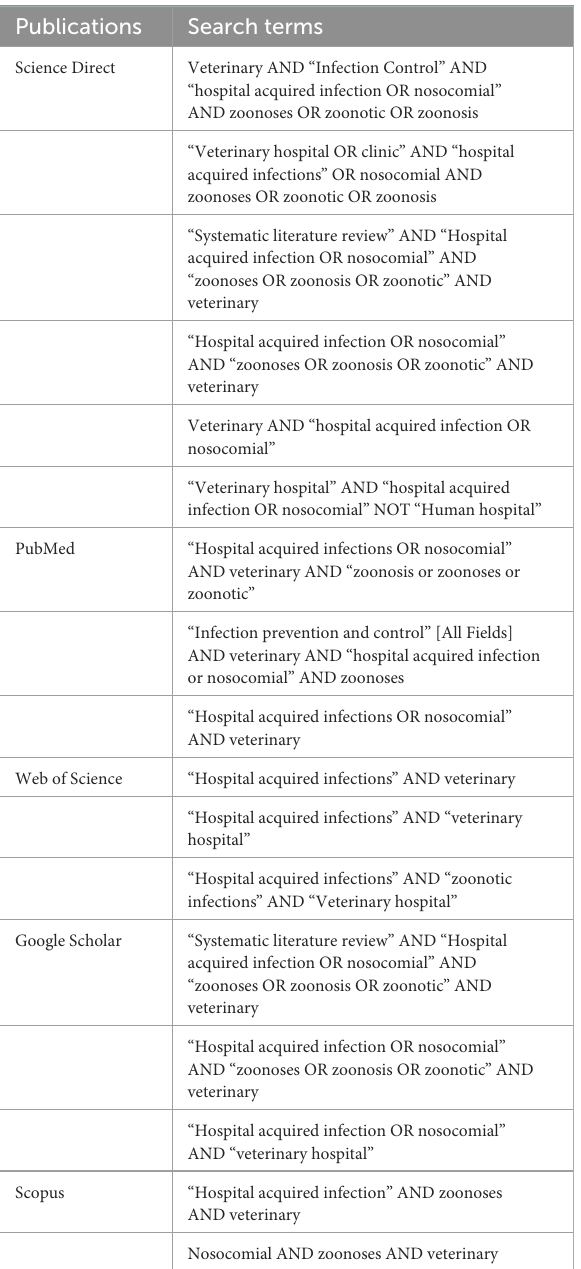
TABLE 2 Inclusion and exclusion criteria of articles reporting on hospital-acquired and/or zoonotic infections in veterinary facilities between 2000 and